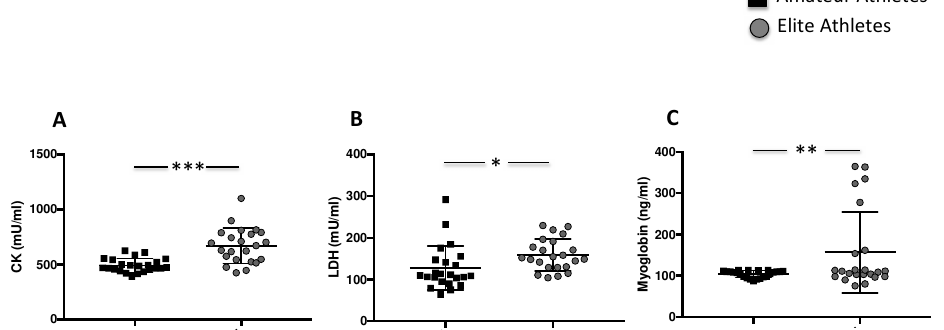
Figure 3. Muscle injury enzymes in amateurs and elite football players. Serum levels CK ( A ), LDH ( B ) and Myoglobin ( C ) in amateurs (n = 23) and in elite athletes (n = 23). (Data are represented as mean ± standard deviation) (*** p < 0.001; ** p < 0.01; * p < 0.05 ).